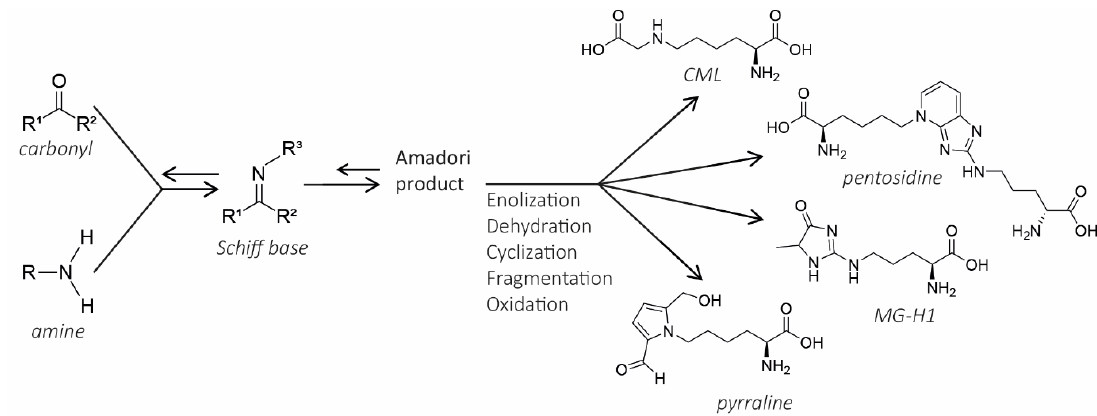
Figure 1. Simplified overview on advanced glycation endproducts (AGEs) formation via the Maillard reaction (MR). As an example, the molecular structure of four di ff erent dietary (dAGEs) are shown. reaction (MR). As an example, the molecular structure of four different dietary (dAGEs) are shown. CML: N”-carboxymethyl-lysine; MG-H1: methylglyoxal-derived